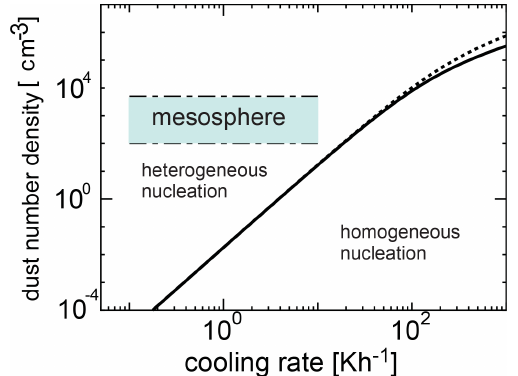
Figure 7. The same as Fig. 6 but for an initial temperature of